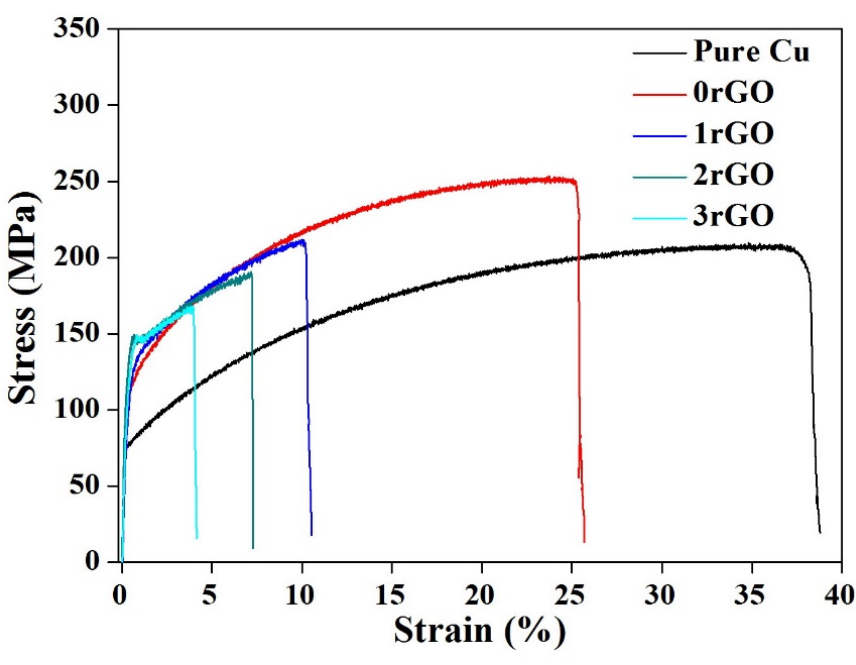
Figure 12. Room-temperature tensile stress-strain curves of the sintered pure copper and bulk compacts. Table 2. Room-temperature tensile properties of the as-prepared bulk compacts and reported CMCs.